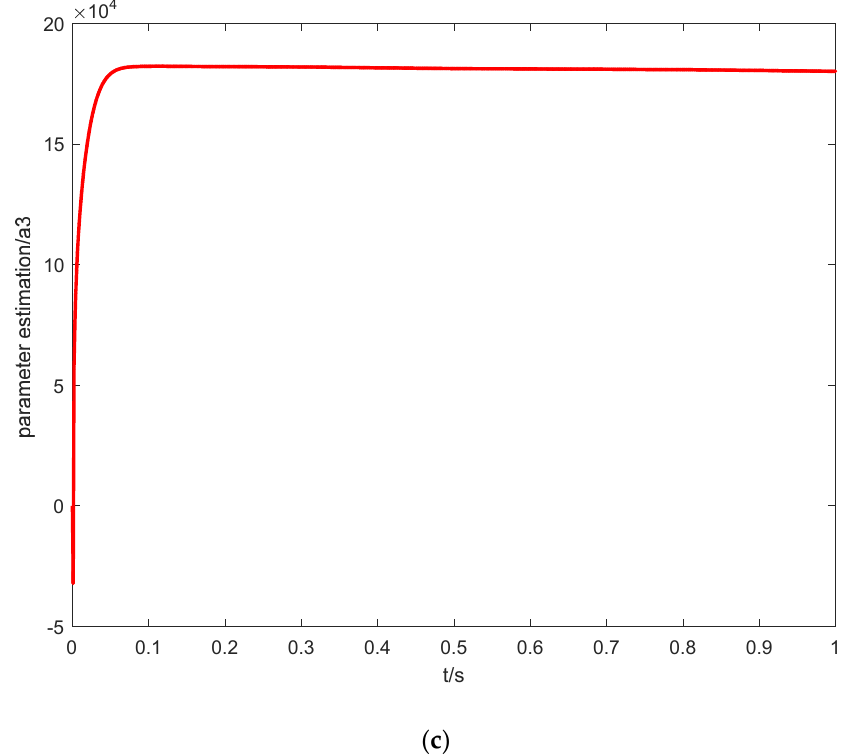
Figure 13. ( a ) Estimation of system parameter a 1 , ( b ) estimation of system parameter a 2 , and ( c ) Estimation of system parameter a 3 . Figure 14 is the change curve of sliding mode in FGFTSMC. It can be found that the sliding mode surface can converge quickly, which verifies that the control strategy has excellent control performance.